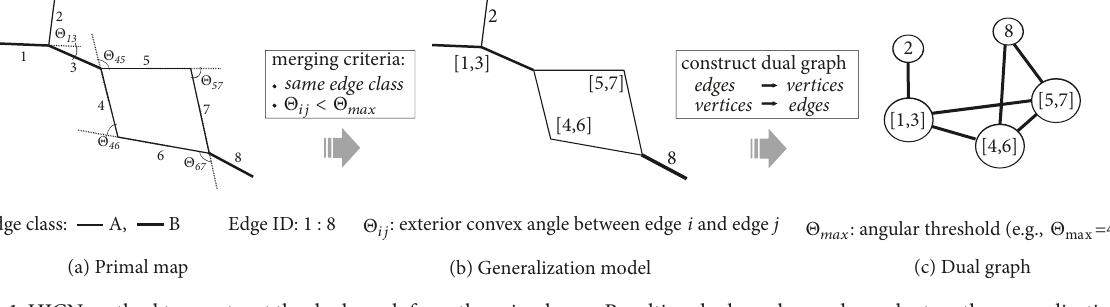
Figure 1: HICN method to construct the dual graph from the primal map. Resulting dual graphs are dependent on the generalization model (adapted from Zischg et al. [28] with permission from ASCE).